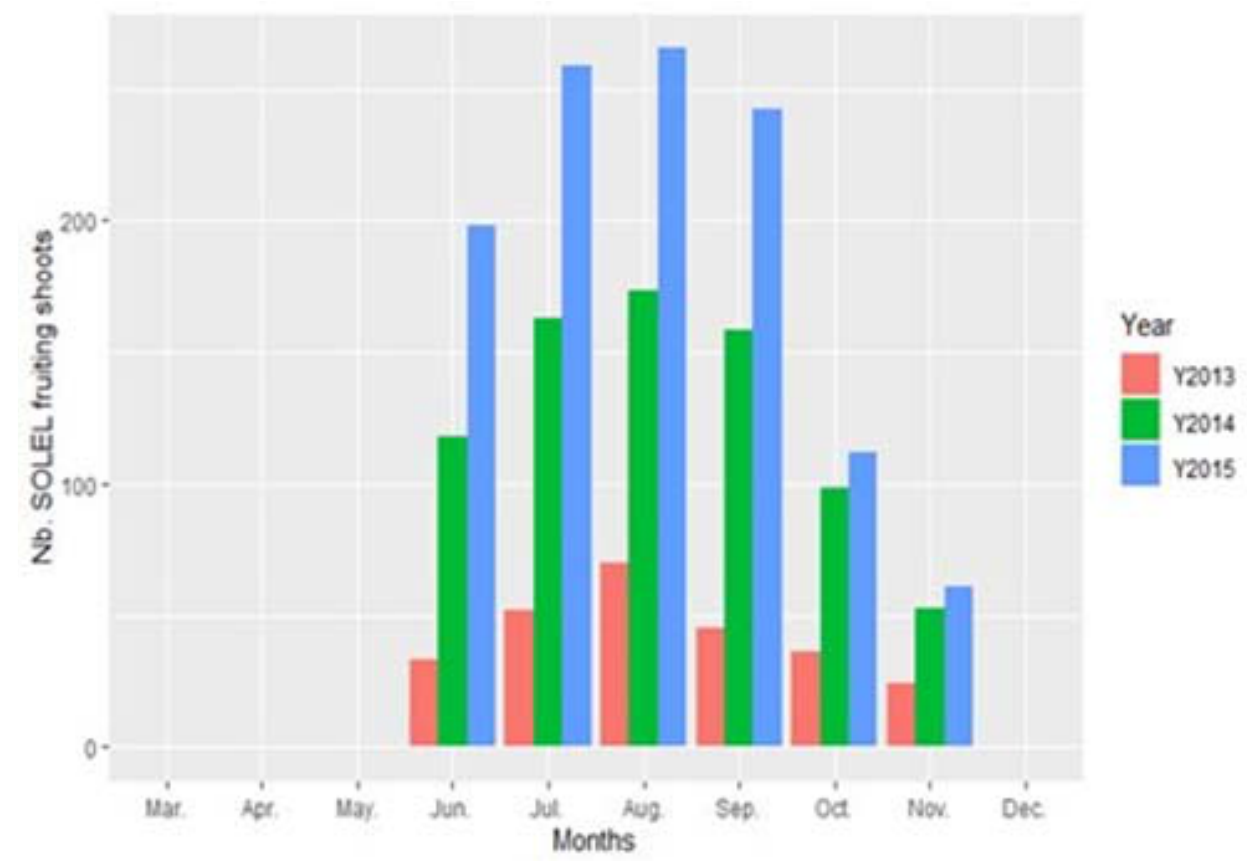
Figure 6. Solanum elaeagnifolium fruiting potential, calculated as the total number of fruiting shoots per month, during three years (2013, 2014, and 2015) at Chott Mariem, Tunisia.